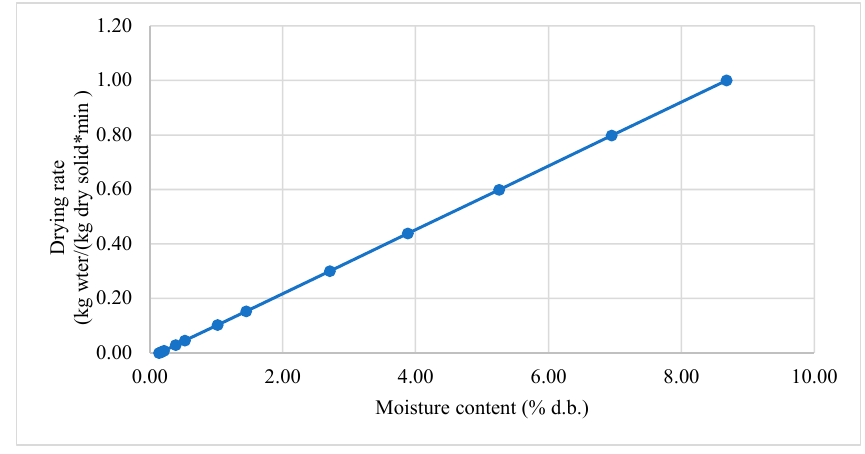
Figure 2. Drying curve of greenhouse solar dryers .